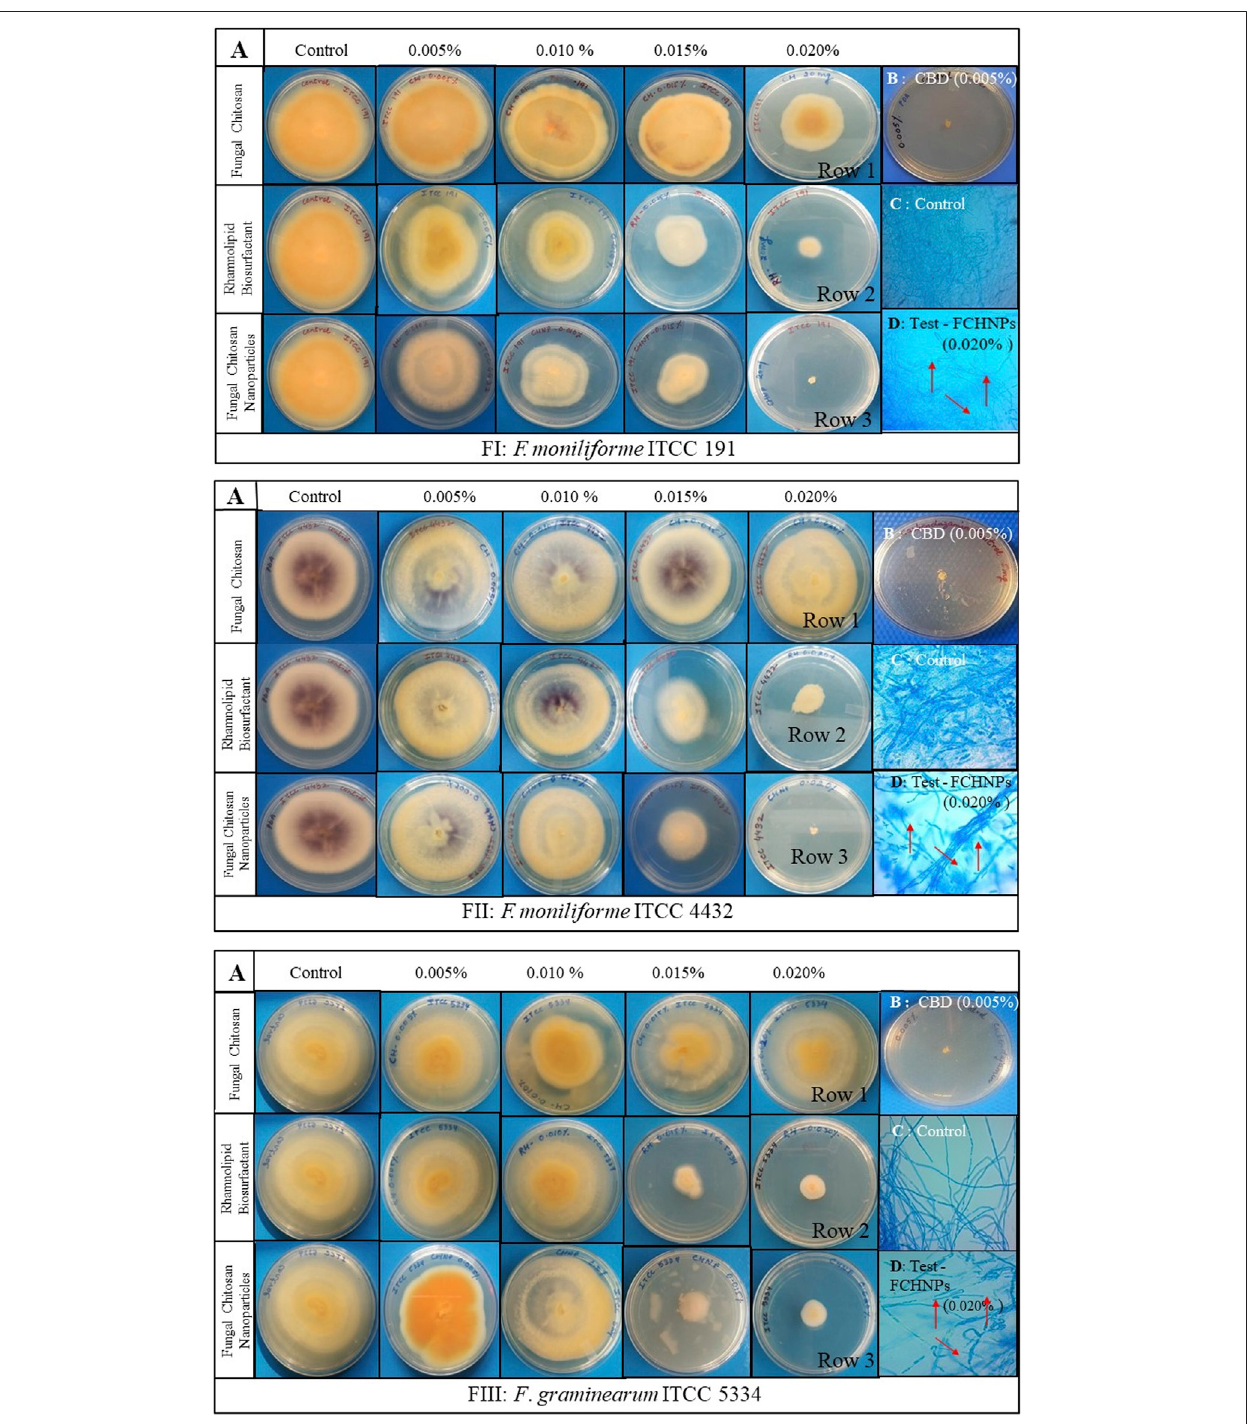
FIGURE6 | In vitro interaction ofrhamnolipid biosurfactant (RH-BS), fungal chitosan (FCH), and synthesized chitosan nanoparticles(FCHNPs) against three fungal phytopathogensFI: F.moniliforme SheldonITCC191,FII: F.moniliforme SheldonITCC4432,andFIII: F.graminearum SchwabeITCC5334depictingthemorphological alterations. (A) Antifungal bioassay demonstrating the effect of the test compounds on mycelial growth of FI, FII, and FIII when treated at different concentrations (0.005%,0.010%,0.015%,and0.020%w/v); (B) CBD:0.005%carbendazim; (C) Control:lactophenolcottonbluestainingoffungalmyceliawithoutanydistortion in absence of the test compounds; (D) Test: lactophenol cotton blue staining of the distorted mycelia of fungi when treated with FCHNPs at 0.020% concentration.